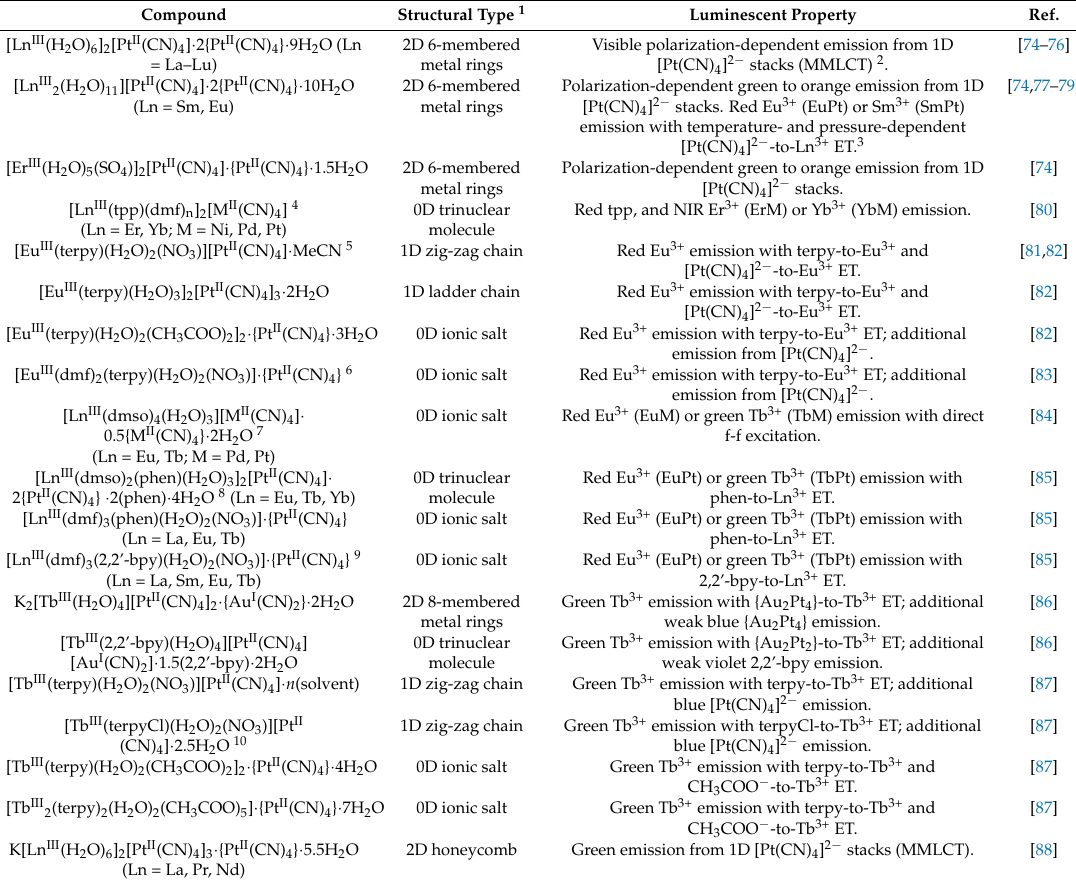
Table 2. Photoluminescent tetracyanidometallate-based compounds containing lanthanide ions.